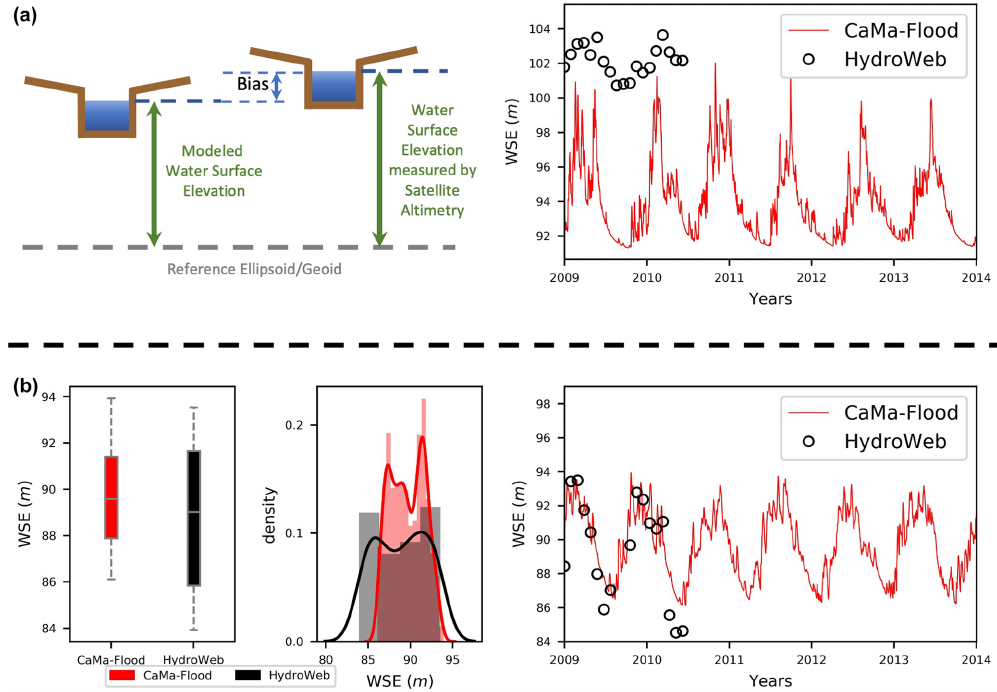
Figure 2. (a) Schematic diagram of the bias between the simulated and observed WSE, and an example of the bias between the simulated and observed water surface elevation (WSE) at the HydroWeb VS R_AMAZONAS_JARI_KM0529. (b) The differences in surface water dynamics shown as a boxplot, probability distribution of simulated and observed WSE, and an example of the difference in amplitude between simulated and observed WSE at the HydroWeb VS R_AMAZONAS_